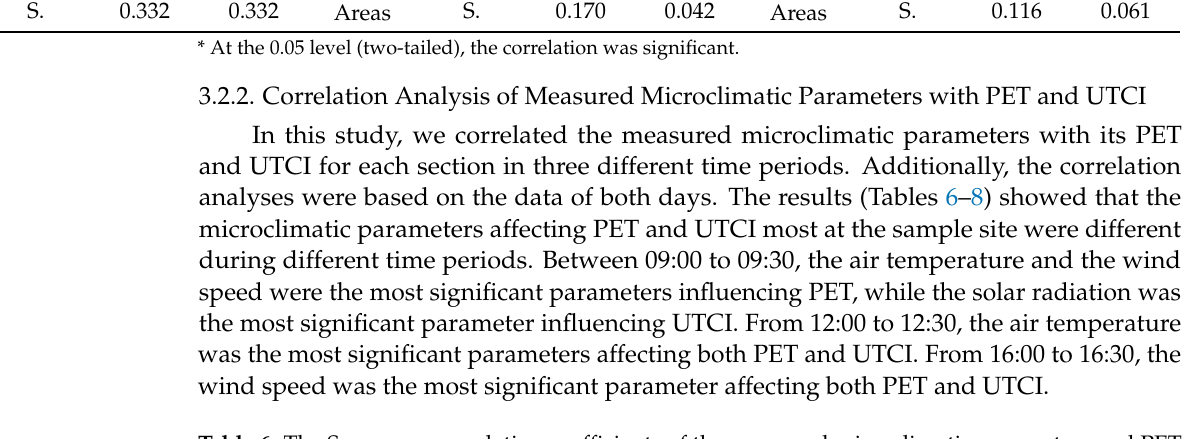
Table 6. The Spearman correlation coefficients of the measured microclimatic parameters and PET and UTCI of 09:00 to 09:30.